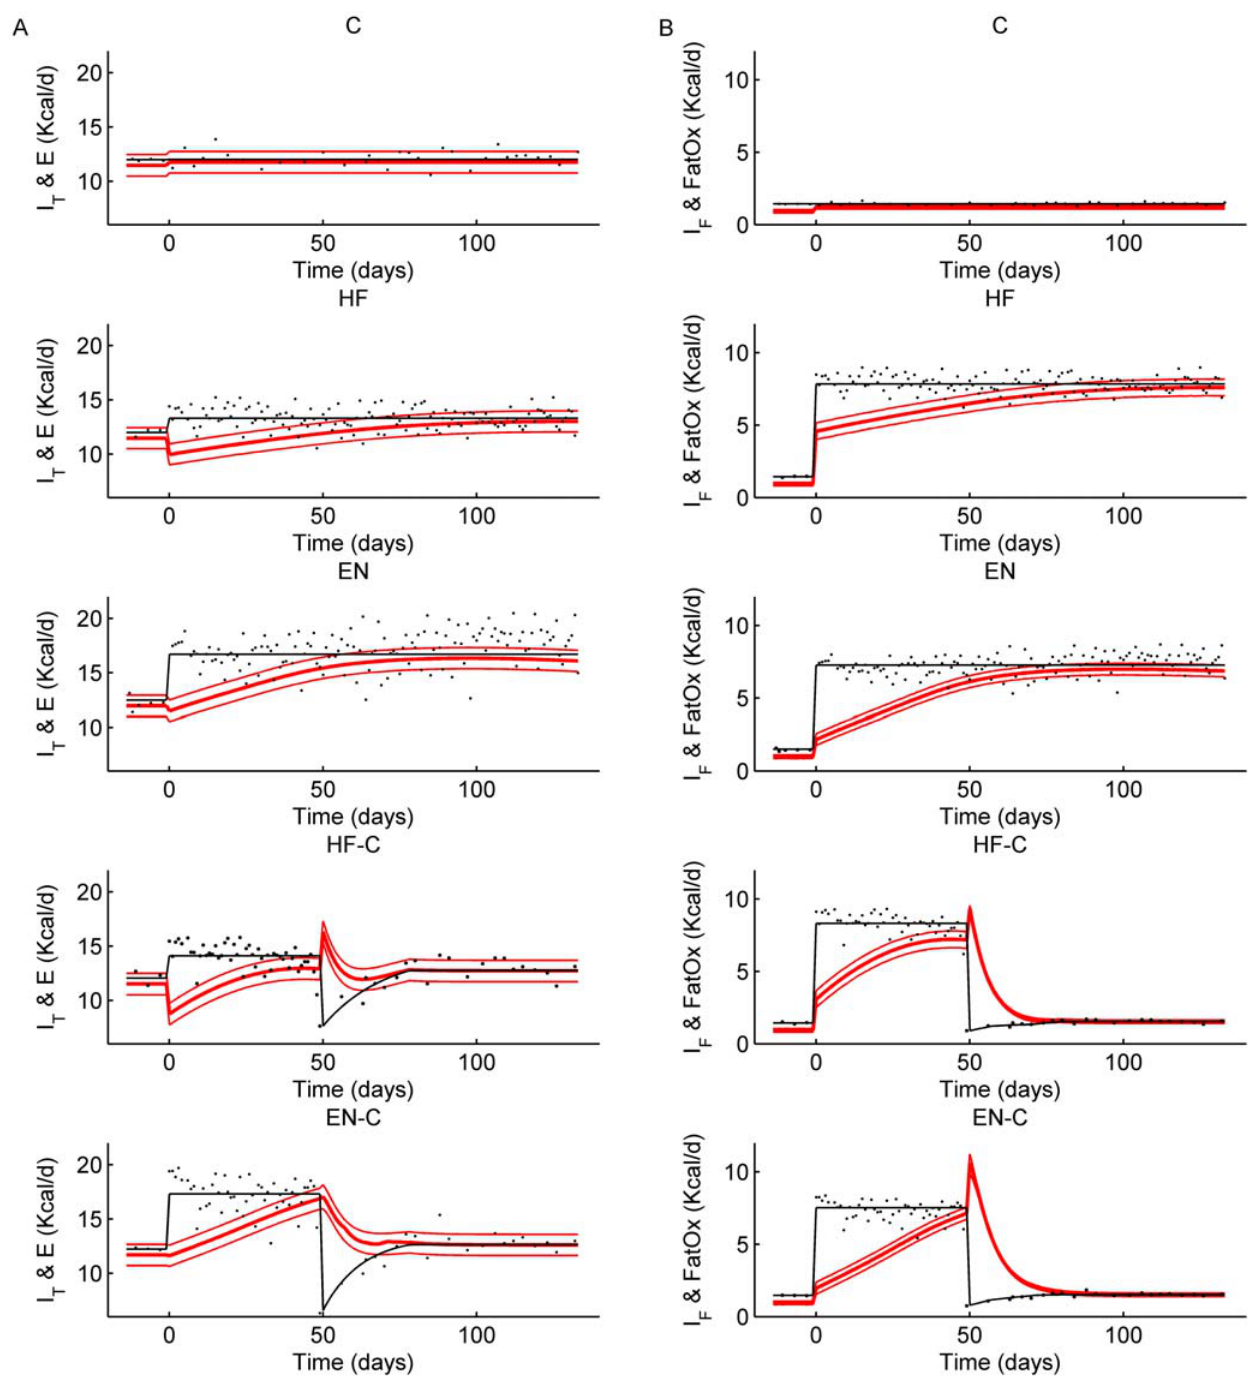
Figure 2. Total energy intake (I T ), fat intake (I F ), and model predictions for energy output (E) and net fat oxidation rates (FatOx) in male C57BL/6 mice. Each row represents one of the five diet groups (C, HF, EN, HF-C, EN-C). Panel A: energy intake measurements (black data points) were fit according to the thin black curves and used as inputs to our model. The model predictions for energy output are shown as thick red curves along with 95% confidence intervals (thin red curves). Panel B: measured fat intake (black data points), average fat intake over each diet period (thin black curves), and model predictions for net fat oxidation rate (red curves) along with 95% confidence intervals.